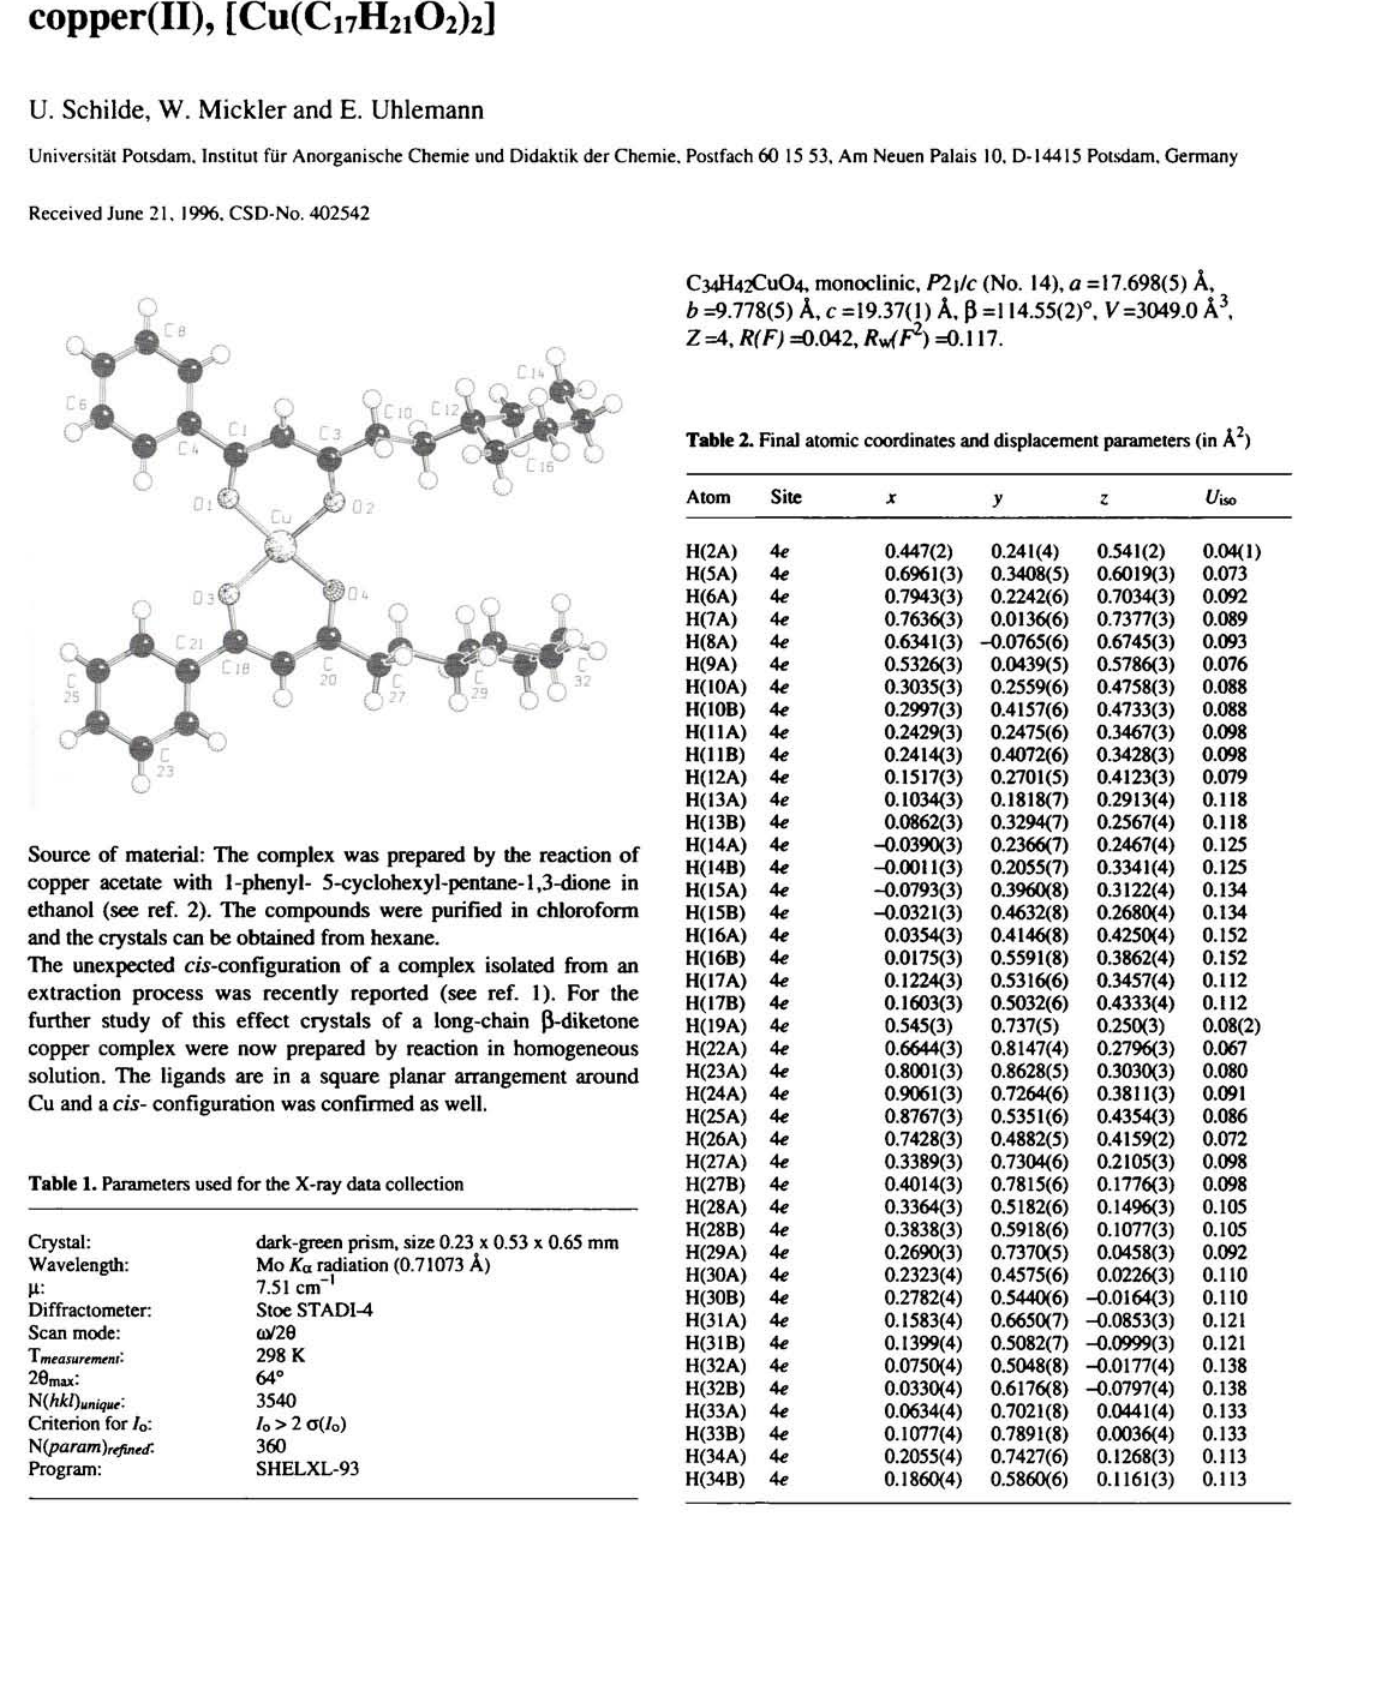
Table 2. Final atomic coordinates and displacement parameters (in A 2